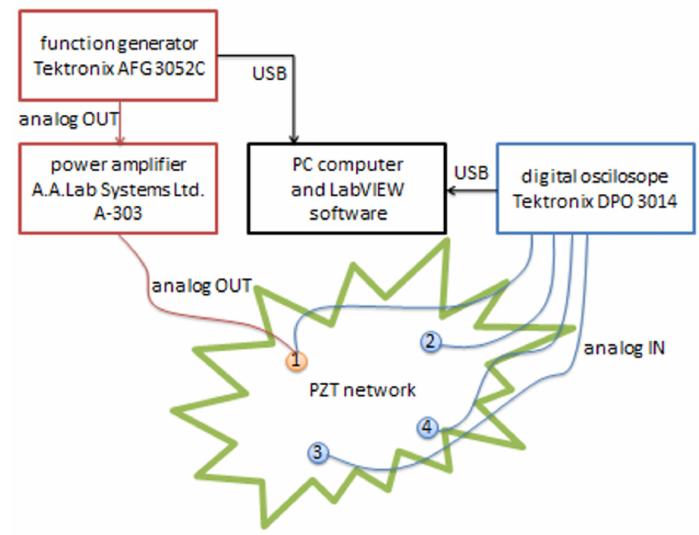
Figure 6. Block diagram of the measurement system.